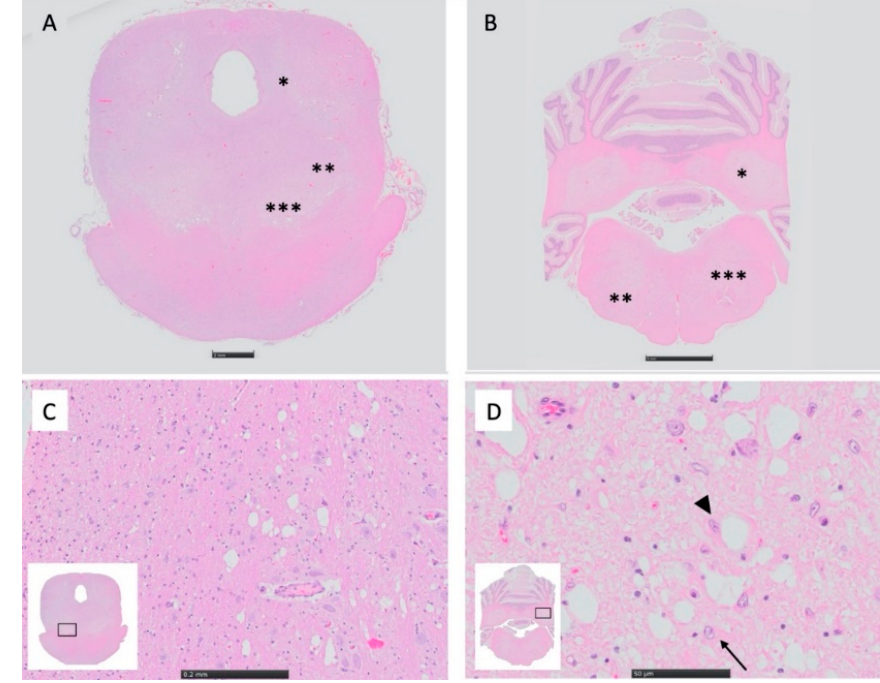
Figure 3. Histopathology of mesencephalon and brainstem from dog 1. ( A ) Bilaterally, the mesencephalic nuclei of cranial nerve V (*), the red nuclei (**), and the substantia nigra (***) exhibit decreased staining intensity (H&E). ( B ) Bilaterally, the deep cerebellar nuclei (*), the dorsal nuclei of the trapezoid body (**), and the reticular formations (***) exhibit decreased staining intensity (H&E). ( C ) Higher magnification of ( A ), inset. The substantia nigra shows prominent vacuolation of affected neurons. ( D ) Higher magnification of ( B ), inset. The interposital nucleus shows reactive astrocytes (arrow), some of which also contain prominent cytoplasmic vacuolation (arrowhead).